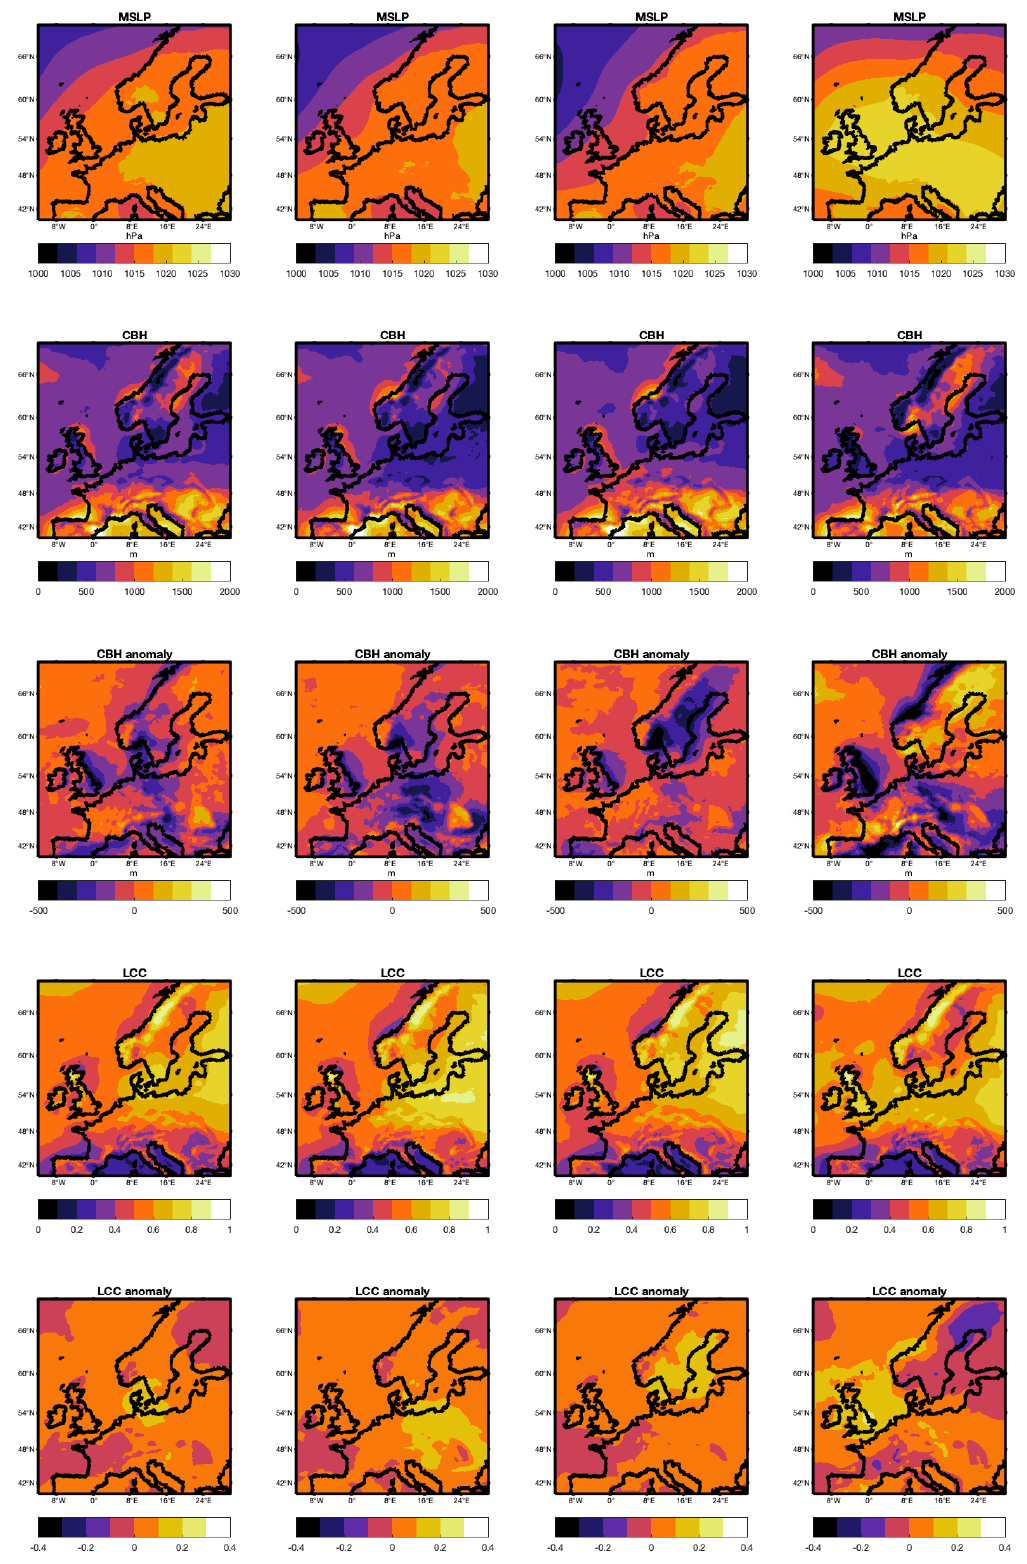
Figure 6. Map of mean sea level pressure (MSLP, top row), cloud base height (CBH, second row), CBH anomaly (third row), low cloud cover (LCC, fourth row), and LCC anomaly (bottom row) during Dunkelflaute periods in Denmark ( left column), Poland ( middle-left column), Sweden ( middle-right column), and the UK ( right column), respectively. Anomaly maps were created by subtracting the monthly mean values from mean values when Dunkelflaute